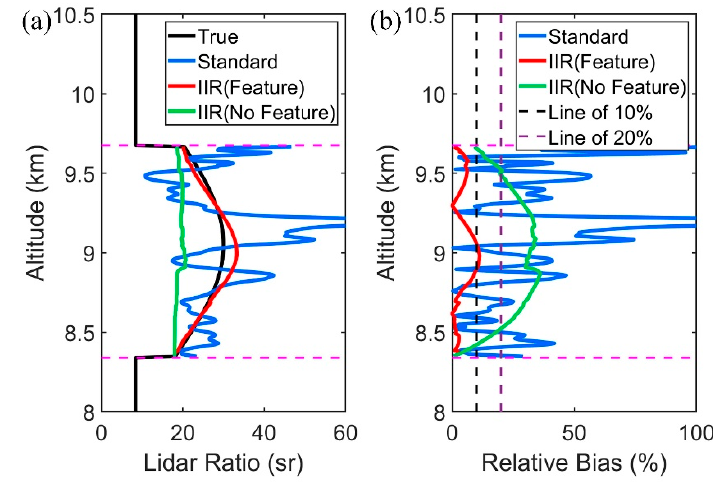
Figure 6. Comparisons of the lidar ratio and the relative biases. ( a ) The profile of the lidar ratio, whose profile number is 78. The line in black is the true values, while the blue, red, and green lines represent the results obtained by the standard method, the IIR method, and the IIR method without feature detection, respectively. The area within the dotted pink line is the valid area of clouds. ( b ) The relative biases of the lidar ratio. The blue, red, and green lines represent the relative biases obtained by the standard method, the IIR method and the IIR method without feature detection, respectively. The black dotted line represents a relative bias of 10 percent while the yellow dotted line represents a relative bias of 20 percent. The area within the dotted pink line is the valid area of the